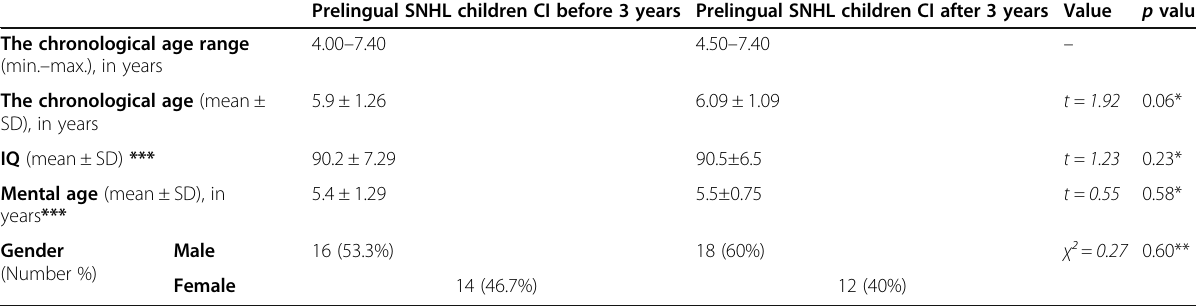
Table 1 The demographic data of the participated children